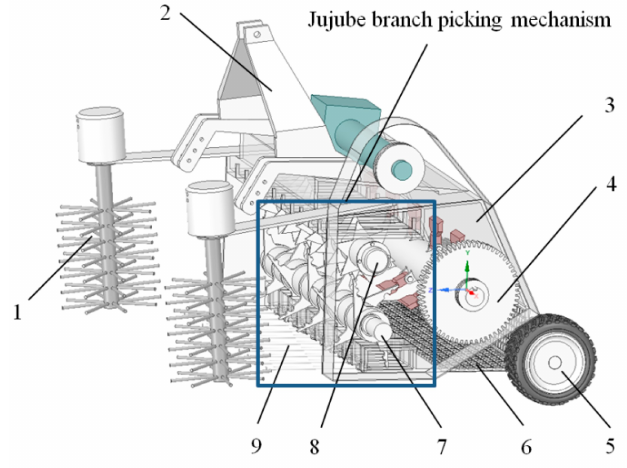
Figure 2. Three-dimensional model of the jujube picking equipment. 1. Rolling brush 2. Traction frame 3. Device shell 4. Crushing mechanism 5. Walking wheels 6. Sieve plates 7. Lower gear assembly 8. Upper gear assembly 9. Collect shovelling teeth.